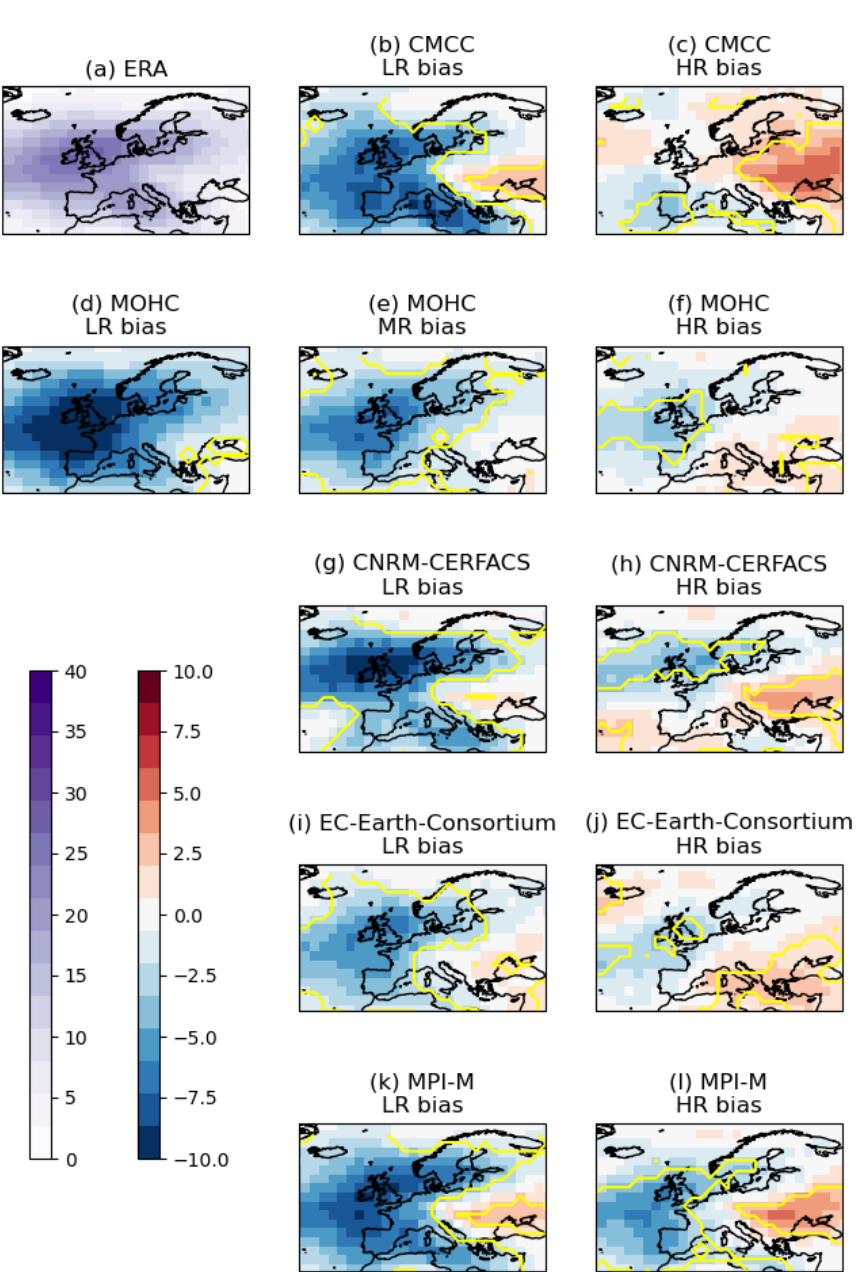
Figure D1. Track density bias (model – ERA) for storms with a non-zero loss index over Europe for individual models for the period October–March 1979/80–2013/14. The yellow contour marks where the bias is statistically different from 0 with 95% confidence according to Welch’s unequal variances t